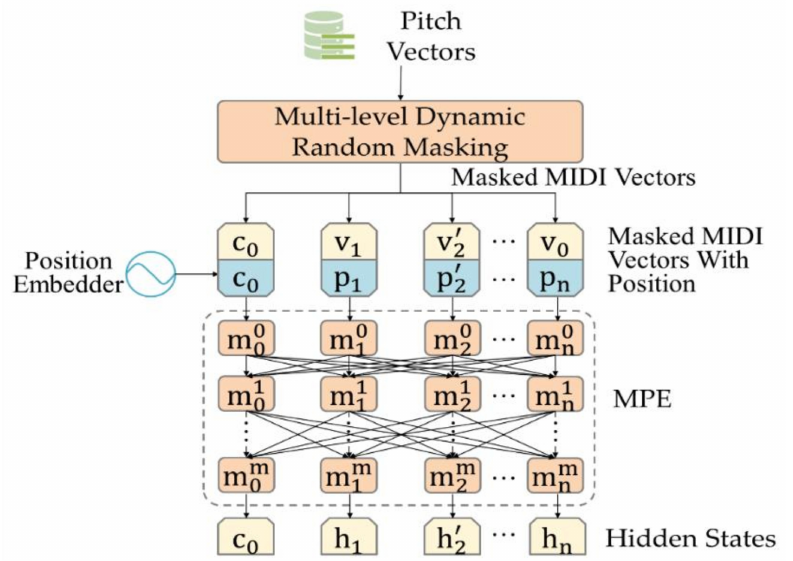
Figure 4. Structure of the MPE. c denotes the classification token that is inputted to CNN. v (cid:48) n denotes the masked vector MASK. p (cid:48) n denotes the position vector. m m n denotes the self-attention transformer